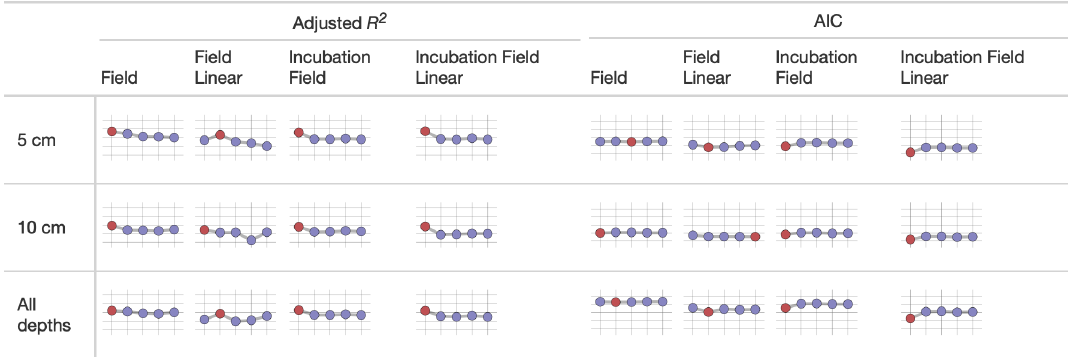
Figure 6. Median values of the adjusted R 2 and AIC from different parameter estimation approaches (field, field linear, incubation field, and incubation field linear) using measurements made at a given depth. The horizontal axis on each sparkline plot is arranged by FireResp submodels (Null, Microbe, Quality, Microbe-mult, and Quality-mult). For the adjusted R 2 sparkline plot, the vertical axis ranges between 0 and 1, with gridlines every 0.25 units. The submodel with the highest adjusted R 2 value is denoted with red coloring. For the AIC plots, the vertical axis ranges from 50 to 250, with gridlines every 50 units. The submodel with the lowest AIC is denoted with red coloring.